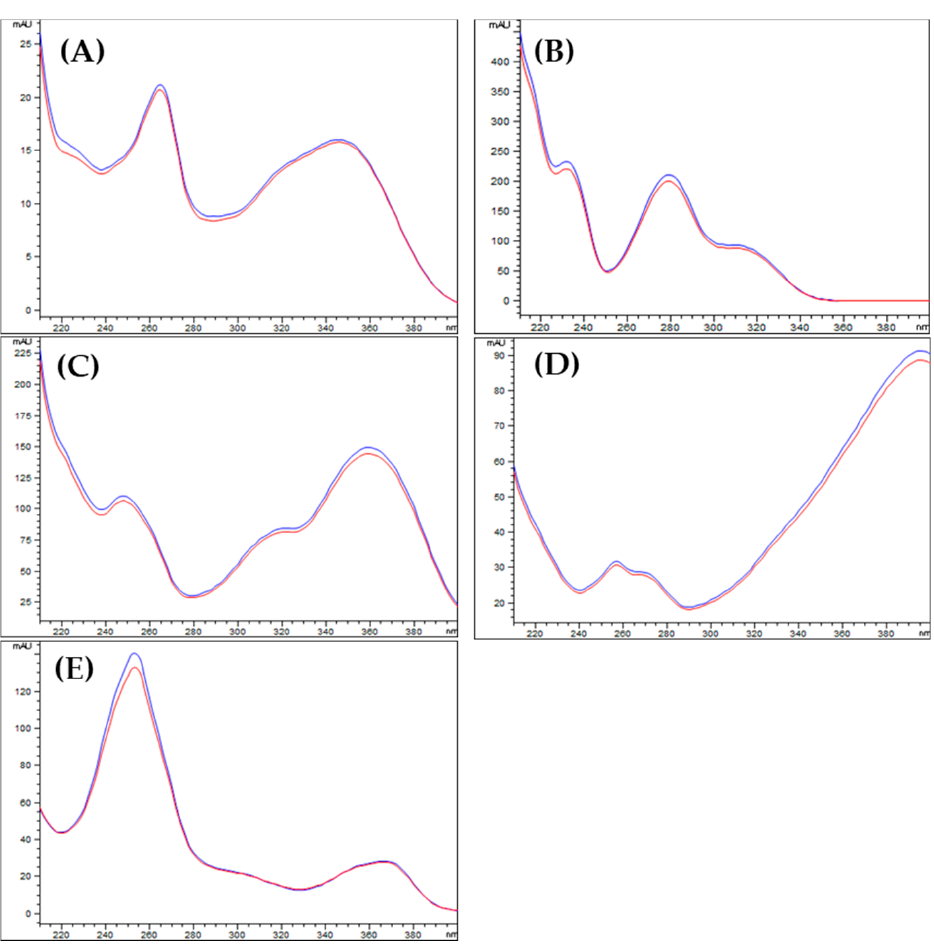
Figure 2. UV spectra of five marker compounds: astragalin ( A ); fustin ( B ); fisetin ( C ); sulfuretin ( D ); and ellagic acid ( E ). The blue curves represent the UV spectra of marker compounds assigned as standards, while the red curves represent the UV spectrum of the marker compound in F2.